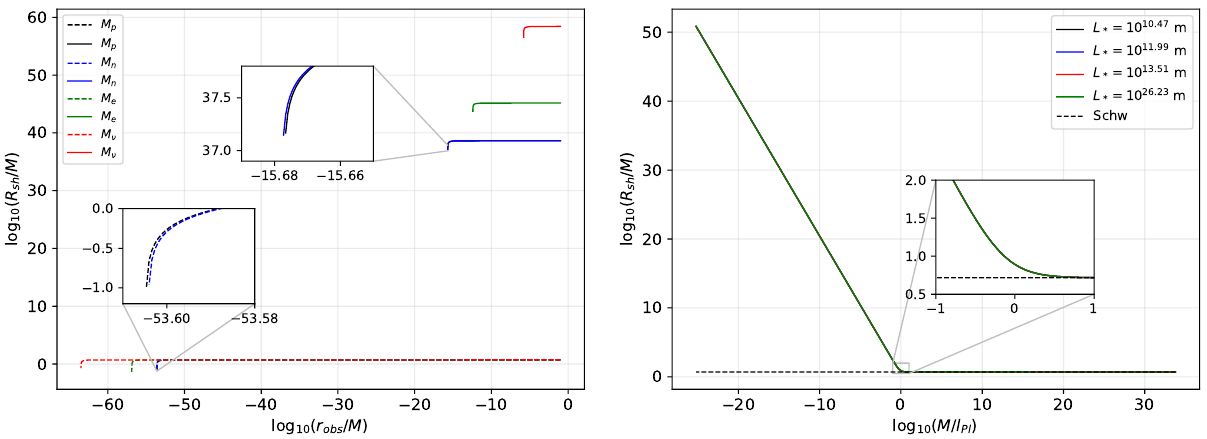
Figure 3. ( Left ): Observer-dependent shadow radius of some elementary particles: proton (p), neutron (n), electron (e), and neutrino ( ν ). ( Right ): The shadow radius plotted under the assumption that the observer/detector is at r obs (cid:29) M , where M is the quantum black hole’s mass, for different values of L ∗ . The overlapping of these lines means that L ∗ has no effect in the microscopic realm. l Pl denotes the Planck